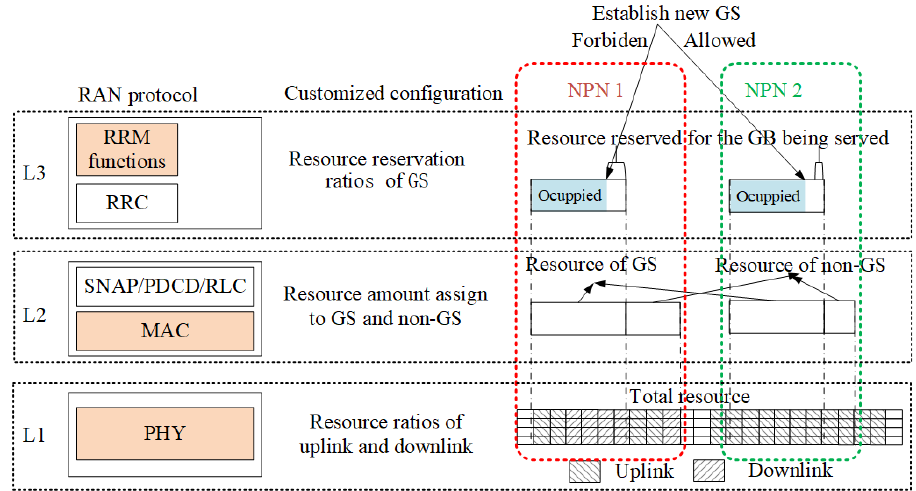
Figure 3. Protocol isolation for RAN.